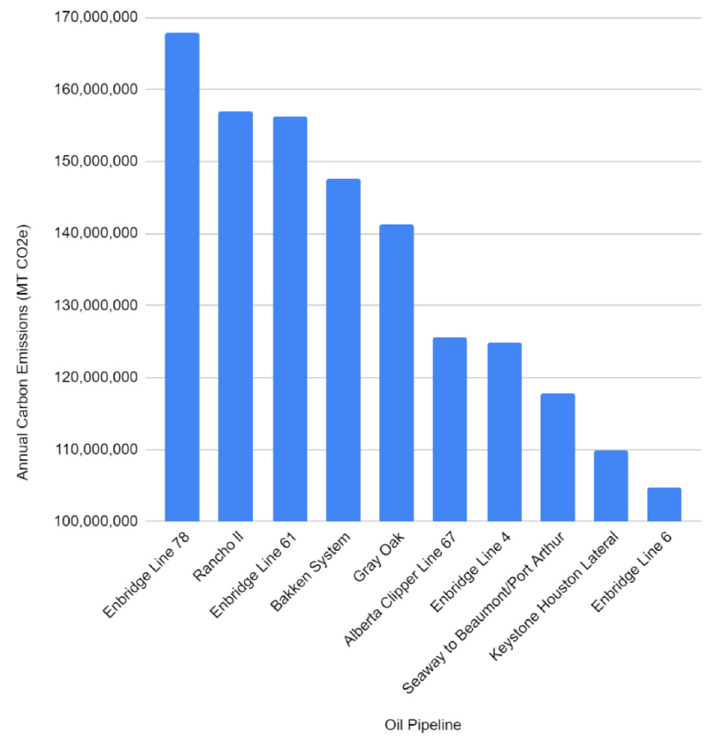
Energies 2020 , 13 , x FOR PEER REVIEW Figure 15 . Top CO 2 Bottlenecks of the Oil Industry for Transport Figure 15. Top CO 2 Bottlenecks of the Oil Industry for Transport.